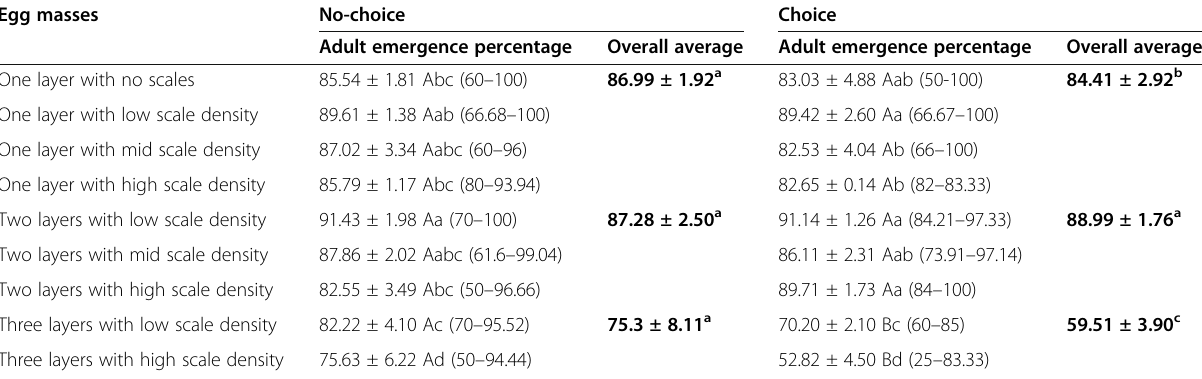
Table 2 Percentages of adults' emergences of T. bactrae from S. littoralis egg masses with different physical characteristics in a no- choice and choice tests